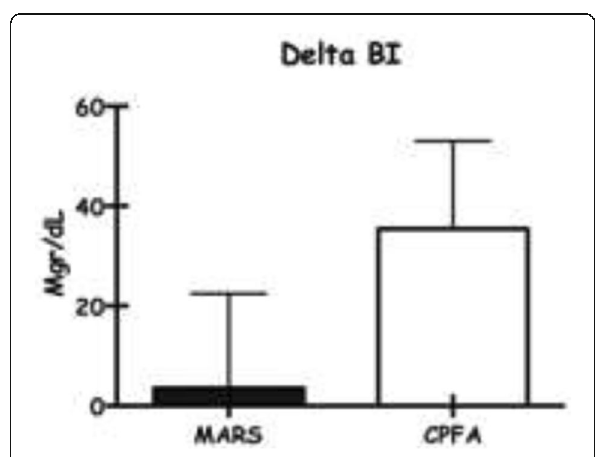
Fig. 2 (abstract 0116). Difference in elimination of indirect bilirubin